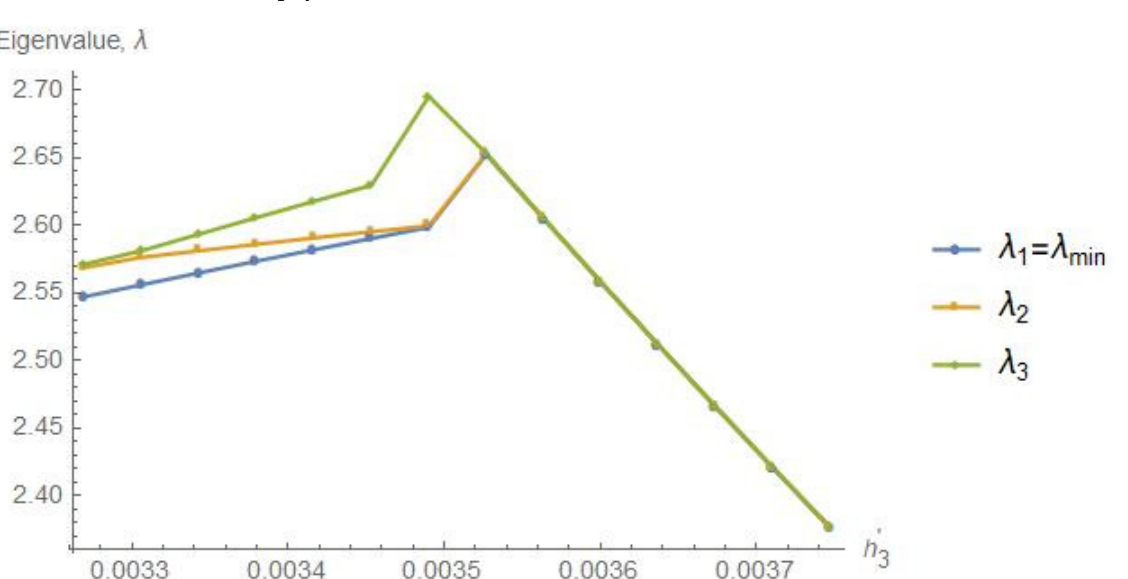
Figure 7. The 3 least eigenvalues λ min , λ 2 , and λ 3 from the ANSYS eigenvalue buckling analysis versus the relative core thickness ℎ (cid:2871)(cid:4593) for payload fraction 𝑞 = 0.1 .